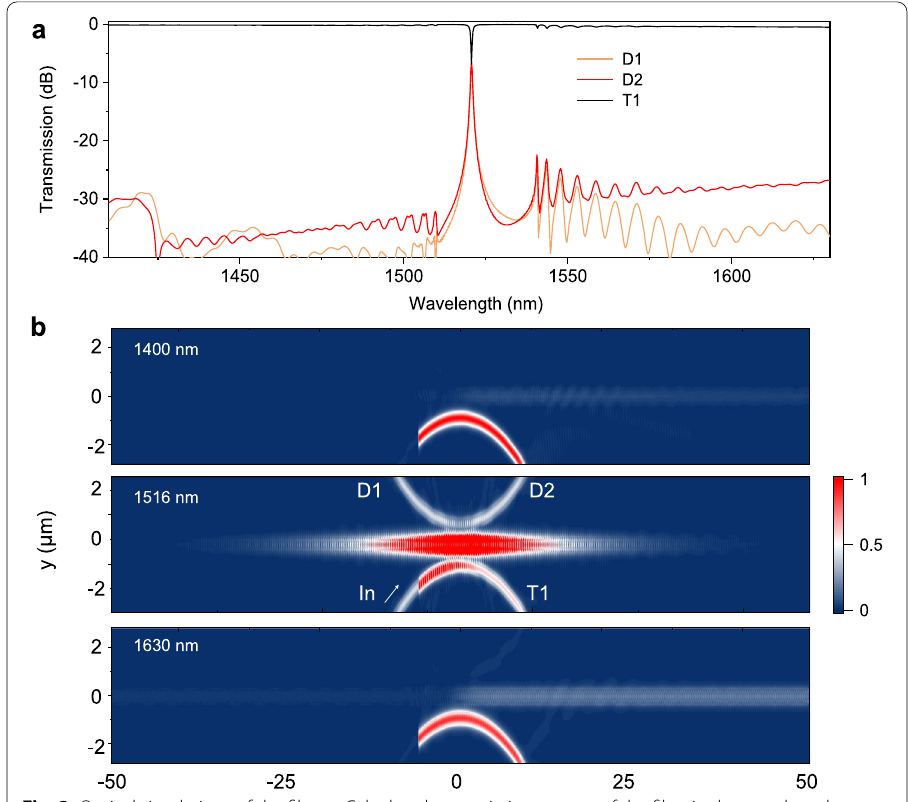
Fig. 2 Optical simulations of the filter. a Calculated transmission spectra of the filter in the wavelength range of 1400–1630 nm at drop ports (D1 and D2) and through port (T1). b Simulated electric field distribution